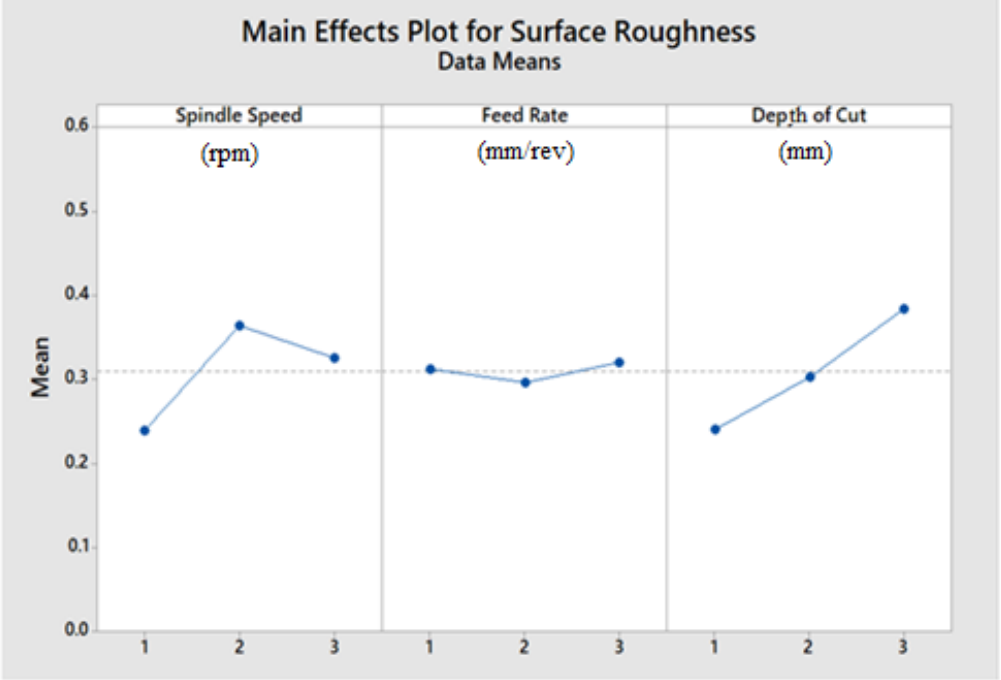
Figure 9. Main effects plot/graph for Ra . Figure 9. Main e ff ects plot / graph for Ra